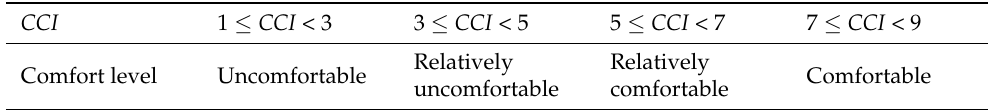
Table 2. The classification standard of the CCI